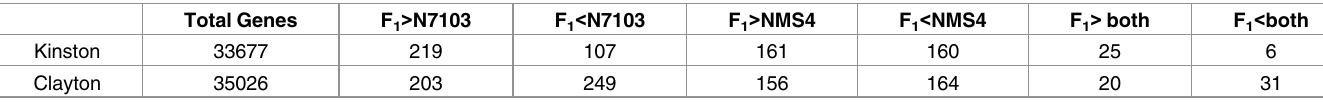
Table 4. Gene counts from gene expression